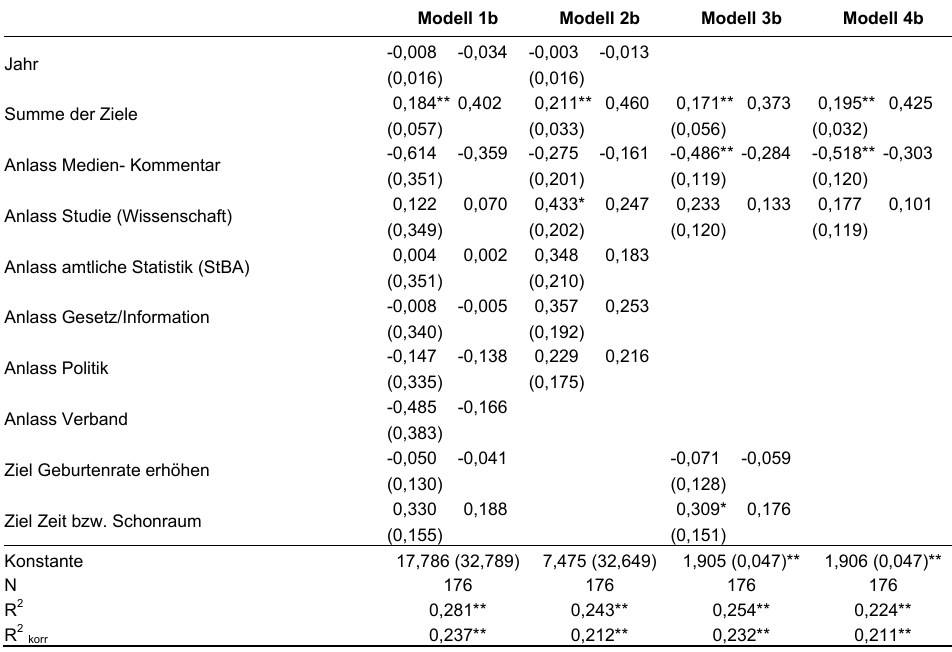
Tabelle 2 : OLS-Regressionsanalyse zu Determinanten der Valenz von Zeitungsartikeln zum Elterngeld 2004-2012 (Gesamtsample inklusive Artikel mit